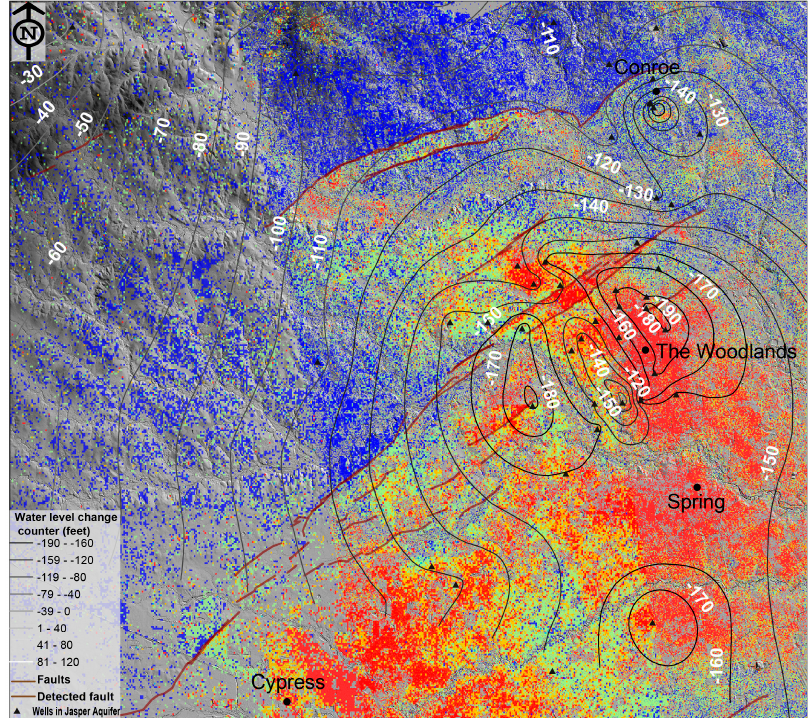
Figure 9. InSAR-observed deformation rate from 2007 to 2011 and the contoured groundwater elevation change at Jasper aquifer for the period 2000–2011 [104]. Black triangles show location of groundwater wells in Jasper aquifer that were used to derive the water level change counters.